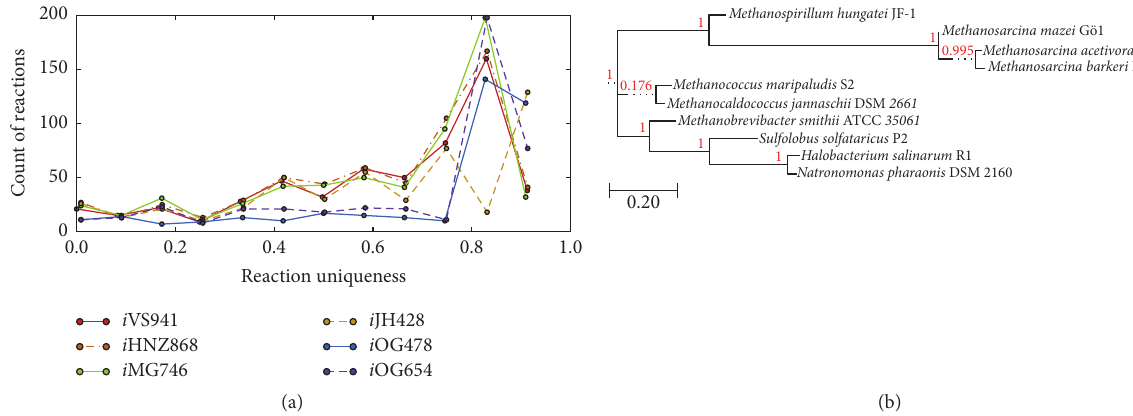
Figure 7: Diversity and phylogeny of metabolic models. (a) The uniqueness of the reactions in each of the metabolic models. Here, we define uniqueness to be the fraction of 221 archaea that do not have the reaction currently present in the respective model; higher uniqueness means fewer of the organisms contain the genes coding enzymes that are annotated by the GPRs of the specified models. The presence of the genes is computed using ITEP as discussed in Figure 5. (b) A phylogenetic tree computed based on similarity to the M. acetivorans model i ST807. This tree is based on the ITEP results discussed in Figure